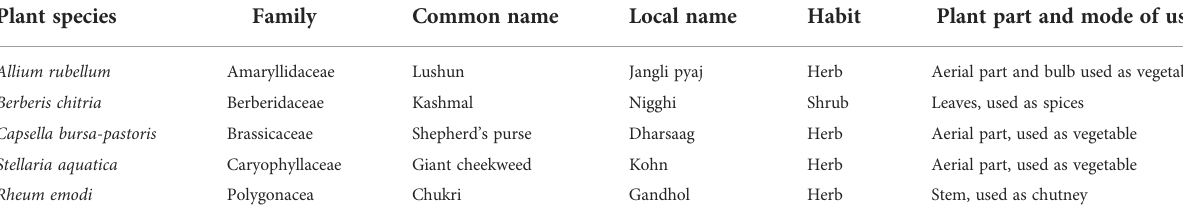
TABLE 1 Descriptions of the fi ve wild edible plants used by Gaddis. Plant species